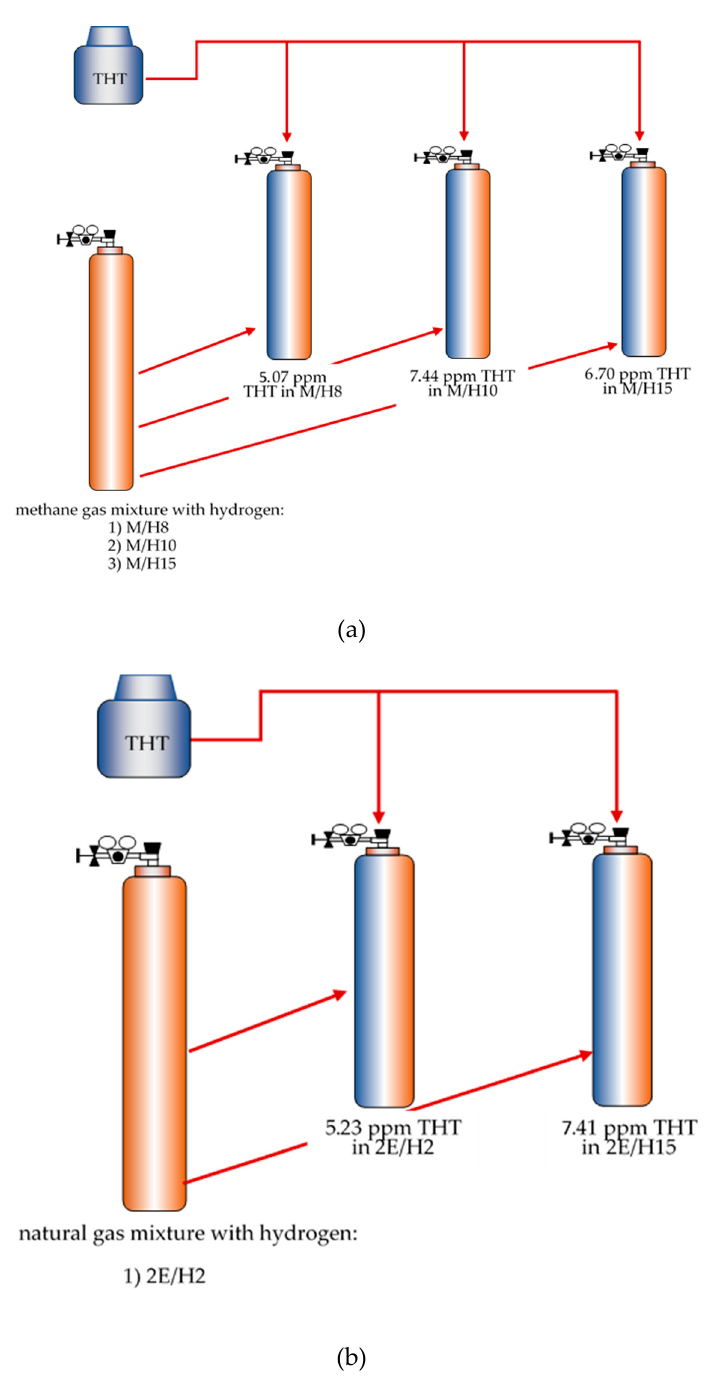
Figure 2. Preparation strategy used to obtain mixtures of tetrahydrothiophene (THT) in methane with the addition of hydrogen ( a ), and in methane-rich natural gas with the addition of hydrogen ( b ).